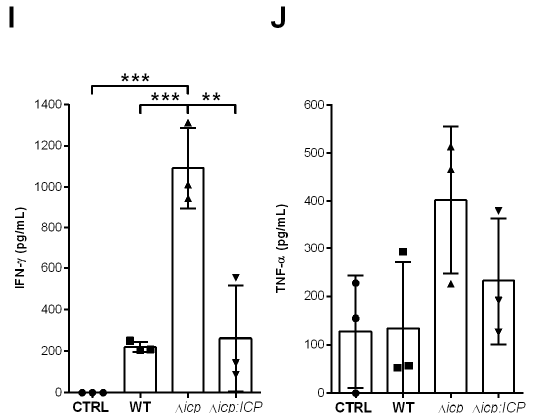
Figure 9. T. b. rhodesiense ∆ icp induces higher inflammatory response in the spleen during early infection of C57BL/6 mice. C57BL/6 mice were infected with BSF parasites of T. b. rhodesiense WT, ∆ icp , and ∆ icp : ICP (1 × 10 5 parasites per animal). On the second day post-infection, mice were euthanized, spleens were removed and macerated, then the splenocytes were submitted to flow cytometry or were cultured for 24 h, after which the supernatant was collected and cytokine levels determined by ELISA. The splenocytes were submitted to flow cytometry to assess expression of ( A ) CD4, ( B ) CD8, ( C ) CD19, and ( D ) NK1.1 within the total cell population. The proportion of the ( E ) Ly6C + Ly6G − and ( F , L ) Ly6C + Ly6G + populations within the CD11b + was determined, while the expression of ( G ) CD11c and ( H ) F4/80 within the total cell population was assessed. Graphs show individual points representing each mouse sample and the mean ± SD of two independent experiments combined (n ≥ 3 per group per experiment). The splenocyte culture supernatants were tested for ( I ) IFN- γ and ( J ) TNF- α . CTRL represents the non-infected control that was injected with RPMI medium. Graphs show individual points representing each mouse sample and the mean ± SD of one experiment (n = 3 or 4 per group per experiment) and are representative of the profile of two independent experiments. Asterisks indicate statistical significance at p < 0.05 (*), p < 0.01 (**), and p < 0.001 (***) as assessed by one-way ANOVA with Tukey’s post hoc